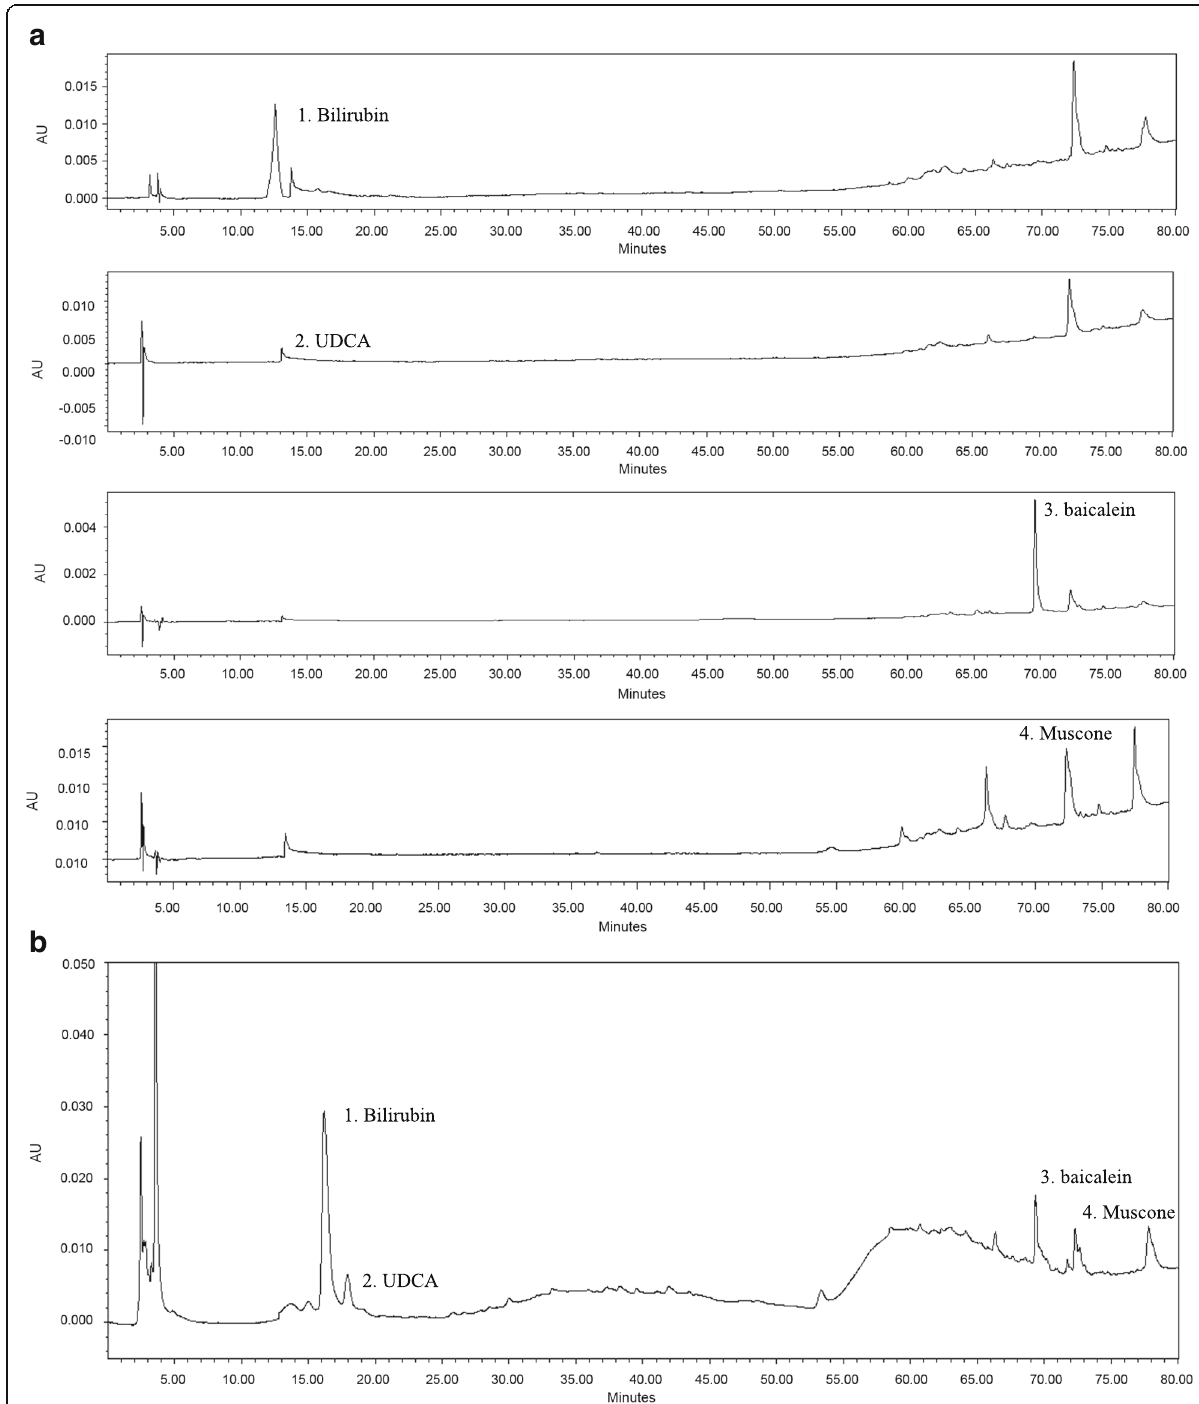
Fig. 9 HPLC pattern analysis of the MOK extract: ( a ) each standard compound. Peaks: (1) bilirubin, (2) UDCA, (3) baicalein, and (4) muscone; and ( b ) MOK